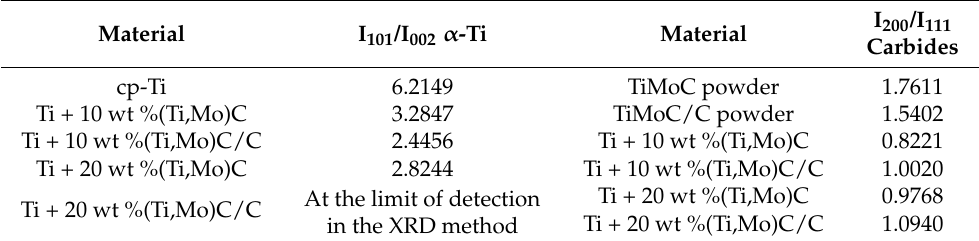
Table 2. Changes in intensity of diffraction peaks in XRD spectra of the